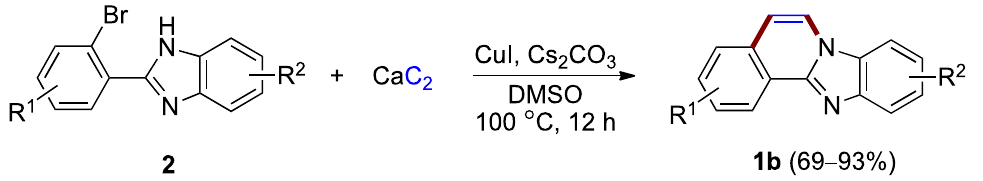
Figure 3. Copper(I)-catalyzed coupling protocol using o -bromophenyl benzimidazoles 2 and calcium carbide as reactants.